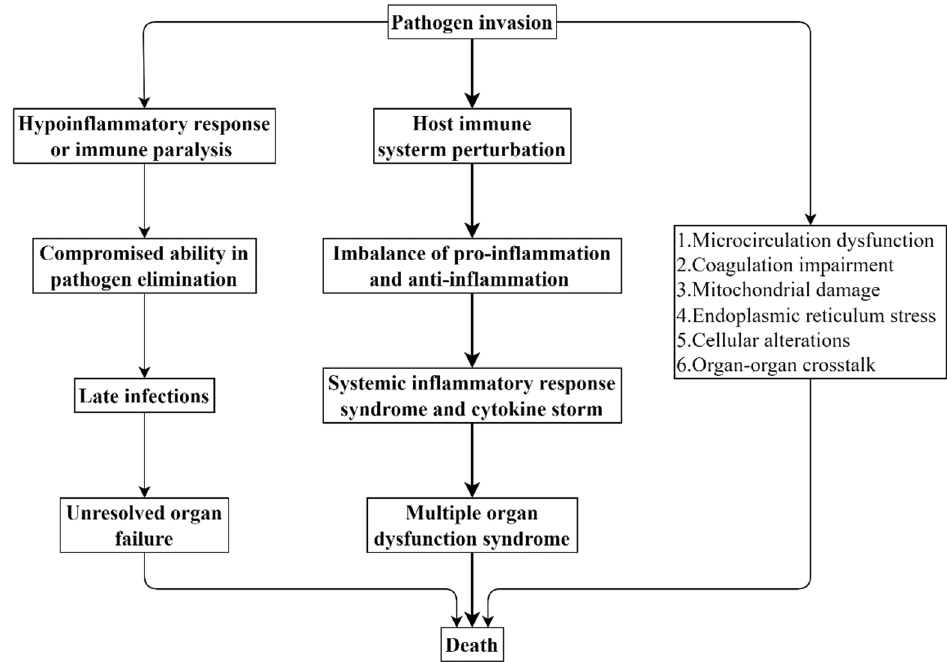
Figure 1. Pathophysiology of